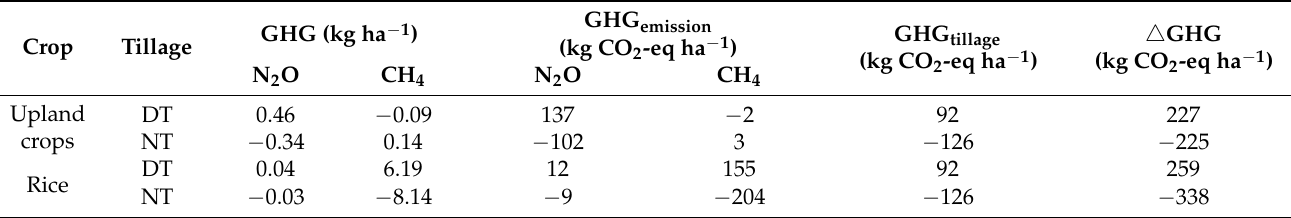
Table 2. Comparison of GHG emissions for different cropping systems under DT and NT compared to RT management plans. Average seasonal emissions of N 2 O and CH 4 , and the GHG emissions caused by fuel consumption are expressed as CO 2 -equivalents. The radiative forcing potentials for N 2 O and CH 4 are 298 and 25 times greater, respectively, than for CO 2 in a 100-year time horizon. GHG, greenhouse gas; DT, deep tillage; NT, no tillage; RT, rotary tillage.